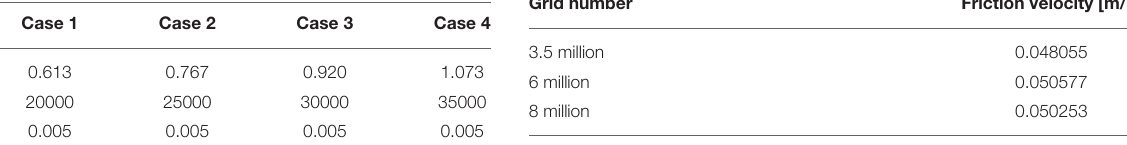
TABLE 3 | Summary of averaged velocity with the corresponding dimensionless numbers.